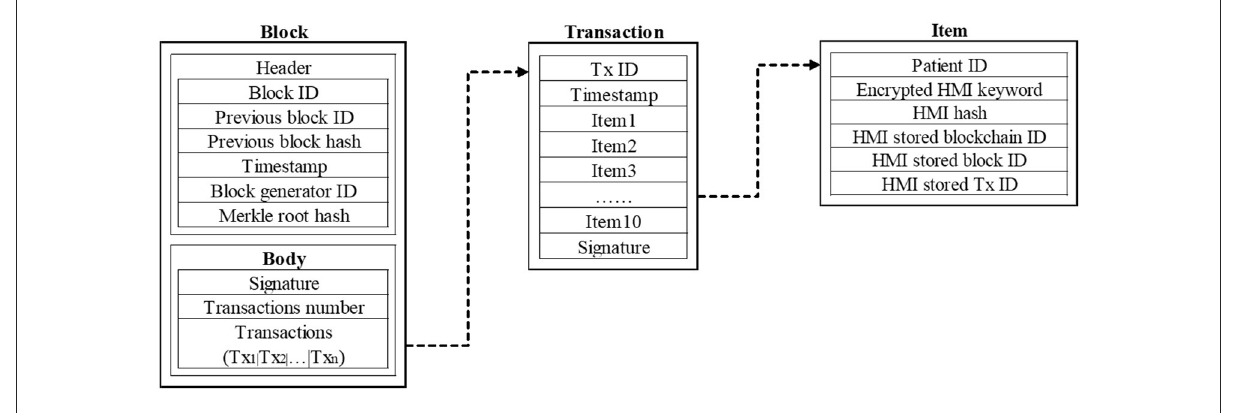
FIGURE4 Structure of a block in the consortium